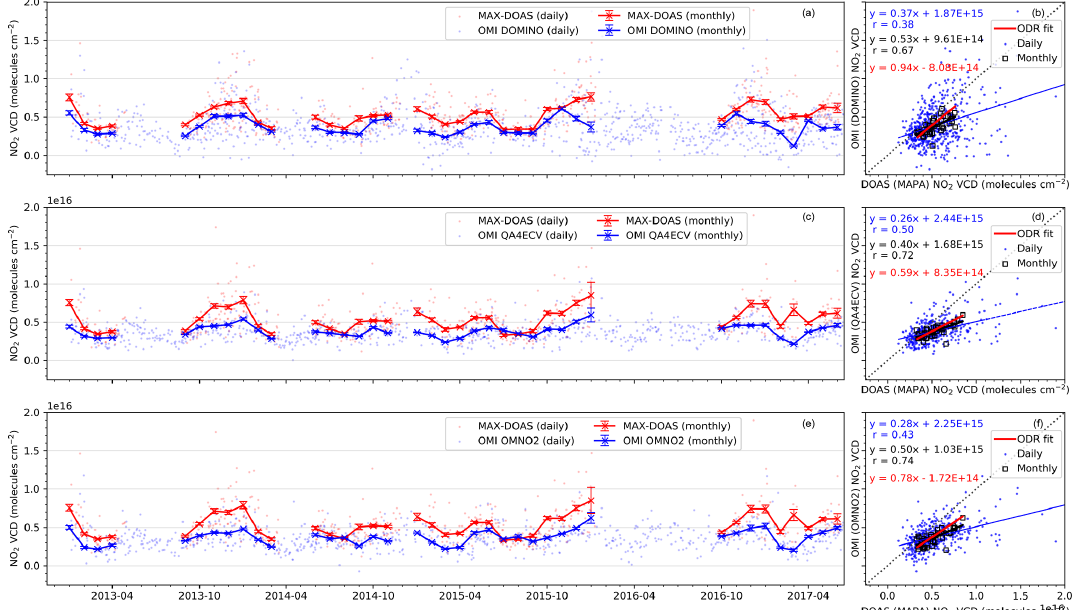
Figure 8. Intercomparison of time series of daily (dots) and monthly mean (lines and markers) NO 2 VCDs retrieved from ground-based MAX-DOAS measurements and the OMI DOMINO data product (a) , the OMI QA4ECV data product (b) , and the OMI OMNO2 data product (c) . The vertical error bars represent the monthly variability as the standard error of the mean. The monthly mean of the MAX- DOAS and satellite data products were calculated by considering only the days of the month when both the measurements were available, causing different MAX-DOAS means in (a) , (c) , and (e) . Scatter plots (panels b , d , and f for DOMINO, QA4ECV, and OMNO2, respectively) using the daily and monthly mean values are shown adjacent to the time series.